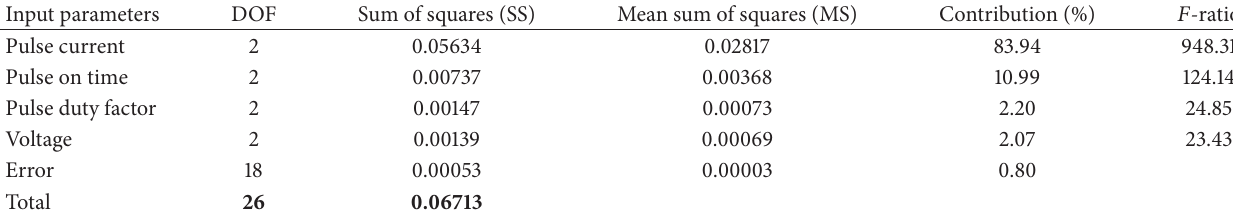
Table 5: Results of